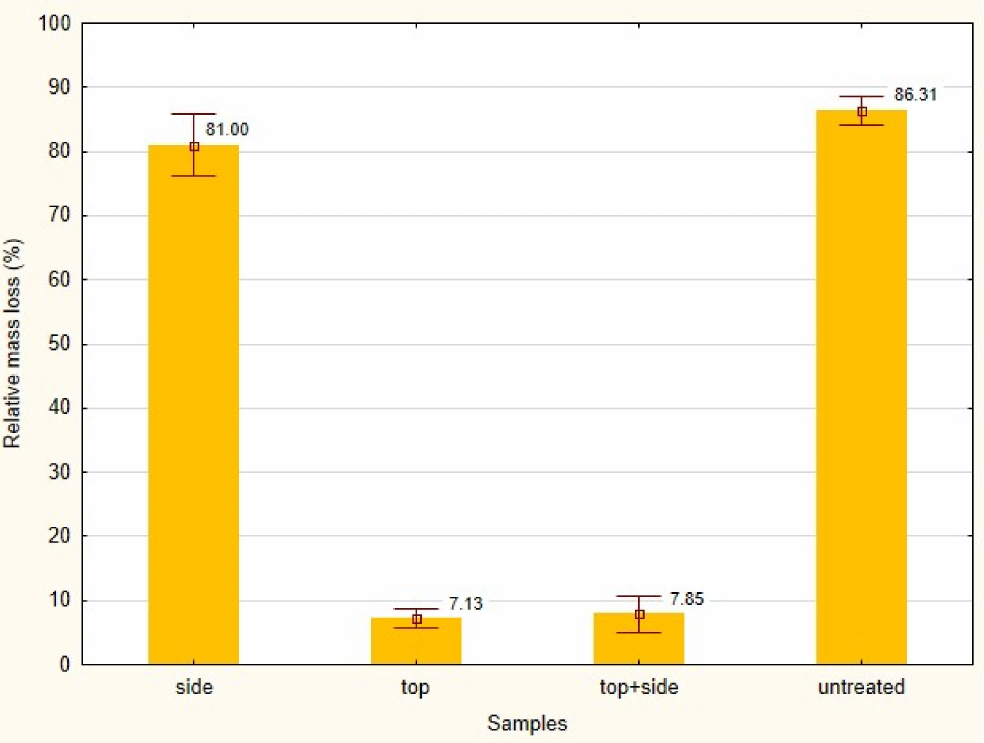
Figure 3. Relative mass loss of wood samples in 600 s (mean ± SD).